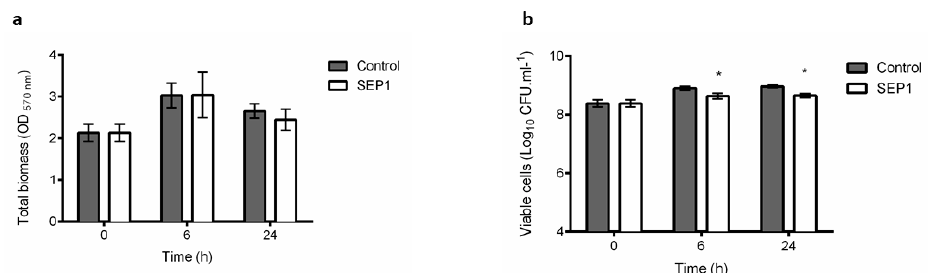
Figure 1. Characterization of the effect of Sepunavirus phiIBB-SEP1 (SEP1) on 24 h S. epidermidis 9142 biofilms, using a MOI 1. ( a ) Effect on the total biomass of biofilms was assessed by crystal violet. staining measured at an optical density OD 570 ; ( b ) effect on the total number of viable cells was assessed by colony-forming unit (CFU) counting. The values represent the mean plus and minus standard deviation of two independent experiments performed in triplicate. Statistical differences ( p < 0.001) between control and SEP1-treated cells (*) were determined by two-way repeated-measures analysis of variance (ANOVA) with Bonferroni post hoc test.